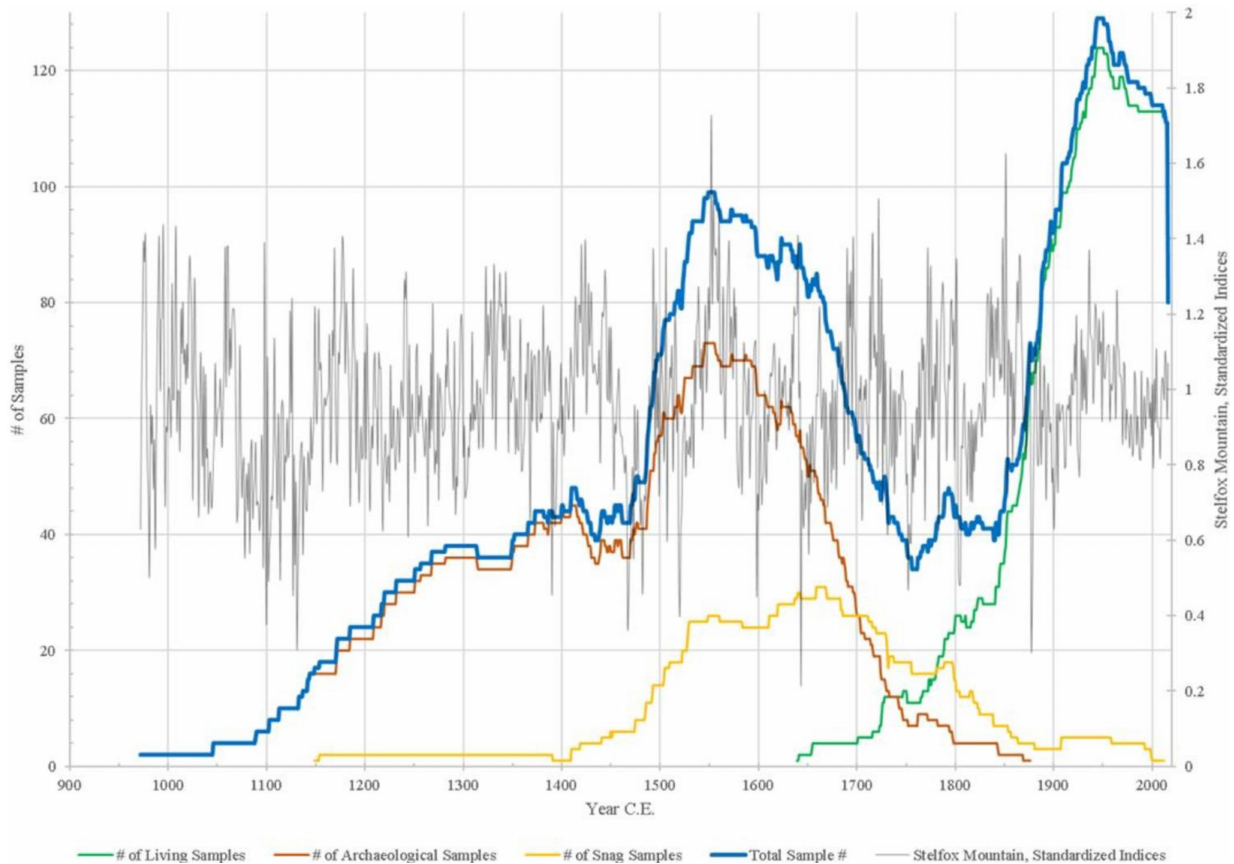
Figure 5. The master chronology (black) and sample depth of the overall chronology (blue), as well as the three components of the chronology. The live cores (green), the dead standing snags (yellow), and archaeological samples